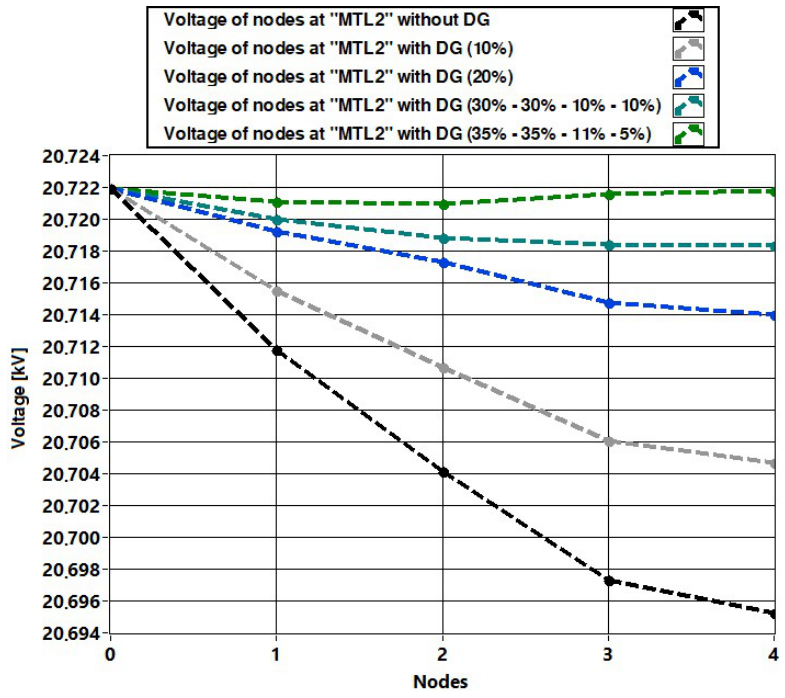
Figure 24. Nodal voltages of the “MTL2” line as the power fed by the DG changes (31 May 2018 at 1:00 pm).